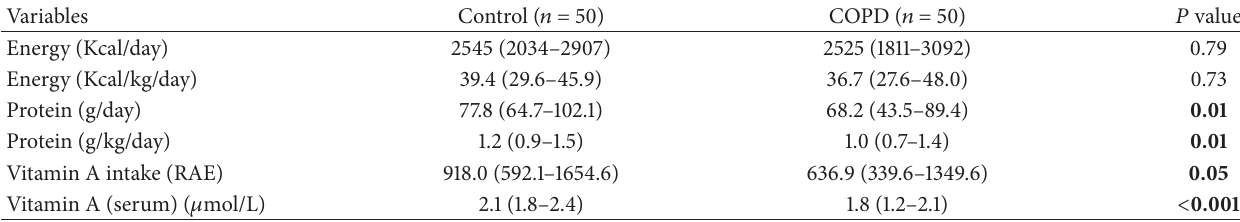
Table 3: Energy, protein, and vitamin A intake and serum vitamin A.